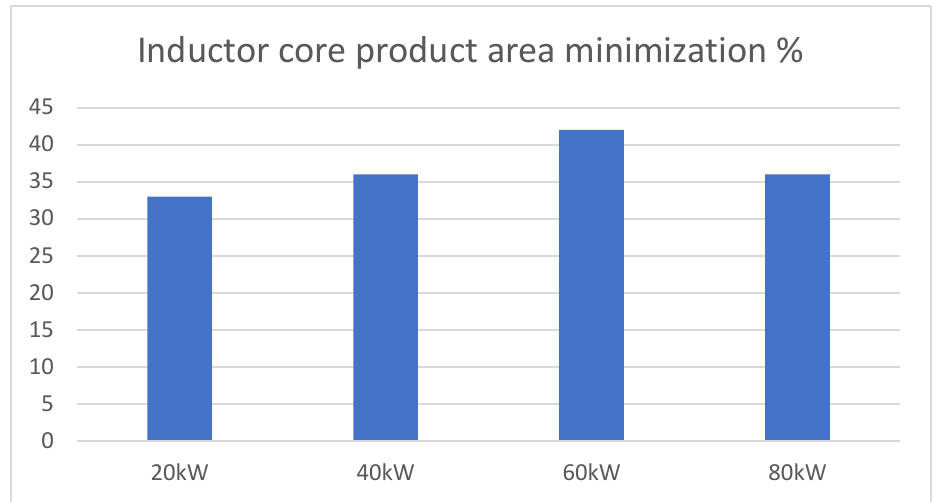
Figure 23. Inductor core product area minimization rate for operation under optimal TrgPS with respect to optimal EPS operation for different values of nominal power.